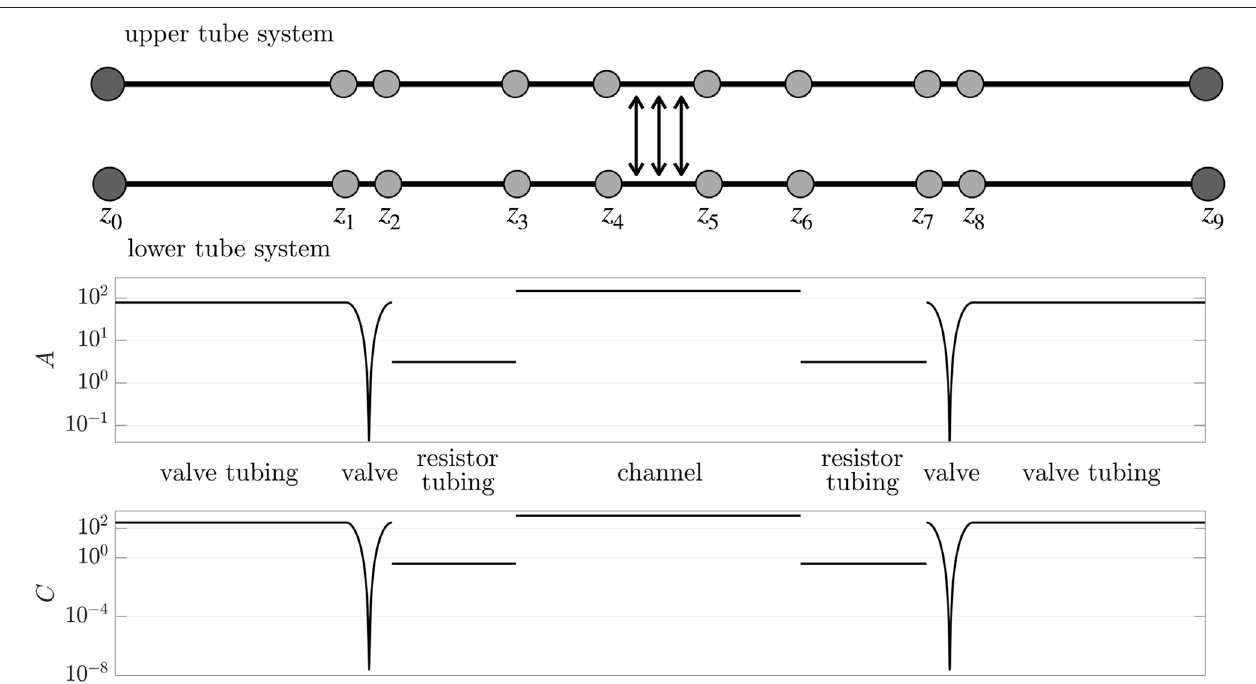
FIGURE 4 | Network diagram of the reduced bioreactor system. At the edges we impose the reduced system ( 14 ) and ( 20 ) with ( 1 ), ( 21 ), ( 23 ), and ( 24 ). The edges are joined by continuity of fl ux and pressure (the light grey nodes). Pressure is prescribed at inlets and outlets (the dark grey nodes). The upper and lower tube systems are coupled due to the scaffold in z ∈ ( z 4 , z 5 ), see Eqs 14 , 23 . Below are plots of the cross-sectional areas and conductivities of each region, where the valve regions are closed ( z -axis not to scale). Parameters are in Table 2